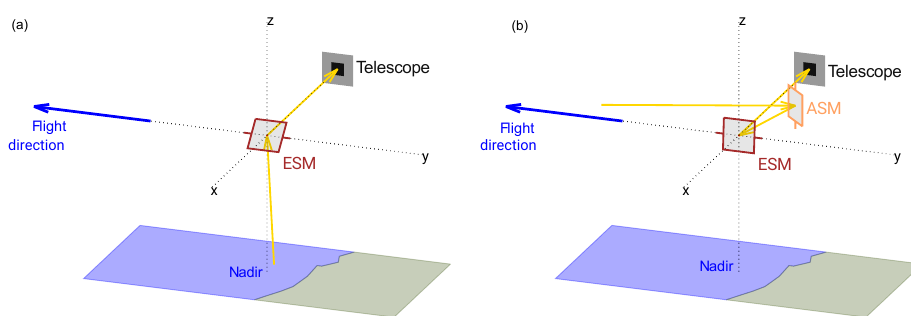
Figure 1. Sketch of the scan mirror configuration and viewing geometry during nadir (a) and limb (b) observations. In nadir mode, the ESM mirror is rotated to achieve a scan across track. In limb mode, the ASM mirror is rotated to achieve a scan across the flight direction, while the ESM mirror performs small steps to select a specific tangent height. Their reflection planes are rotated with respect to each